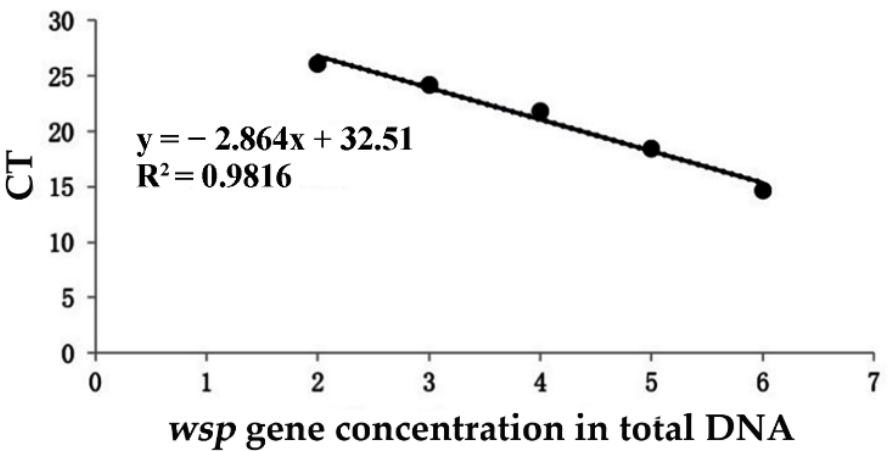
Figure 2. The standard curve of wsp gene obtained from real-time PCR. The relative amounts of wsp gene to total DNA ( wsp gene concentration) in various samples, including four different geographic locations, different insect body parts and ages, and from both sexes of tea green leafhopper were determined by real-time PCR. The wsp gene concentration in total DNA could be calculated using the standard curve equation from Figure 2 and obtained content of Wolbachia in different samples (Figure 3).